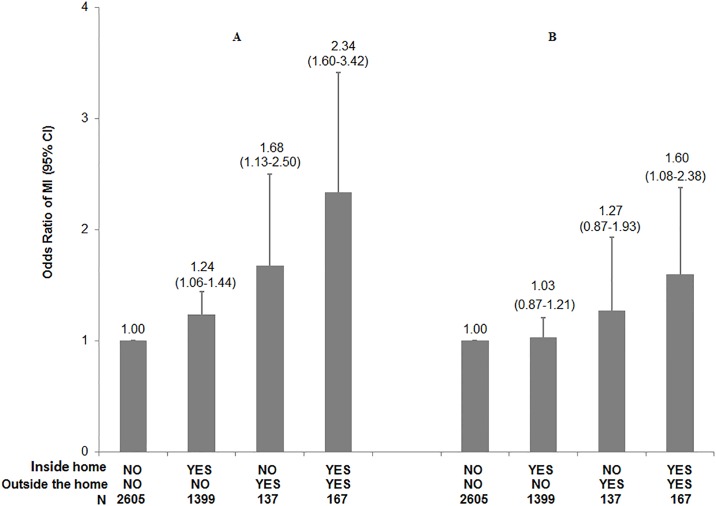
Joint effect of eating fried food ≥4 times/week at home and outside of the home.Odds Ratio (OR) of MI (95%CI) according to the joint category of fried food intake at home and outside of the home; All models used a fixed sample size of 2,154 case-control pairs, ORs conditioned on matching variables (age, sex and area of residence).A:, Adjusted for history of diabetes (yes/no), hypertension (yes/no), smoking (never, past, <10 cigarettes/d, 10–19 cigarettes/d, and ≥20 cigarettes/d), waist-hip-ratio (quintiles), physical activity (quintiles), income (quintiles), educational years, intake of alcohol (never, past, and tertile of current drinkers) and occupation (retired, agriculture, plumbers, semi-skilled or driver, managers and administrators, professionals and others);B: Further adjusted for saturated fat, fiber and total energy intake (all in quintile).